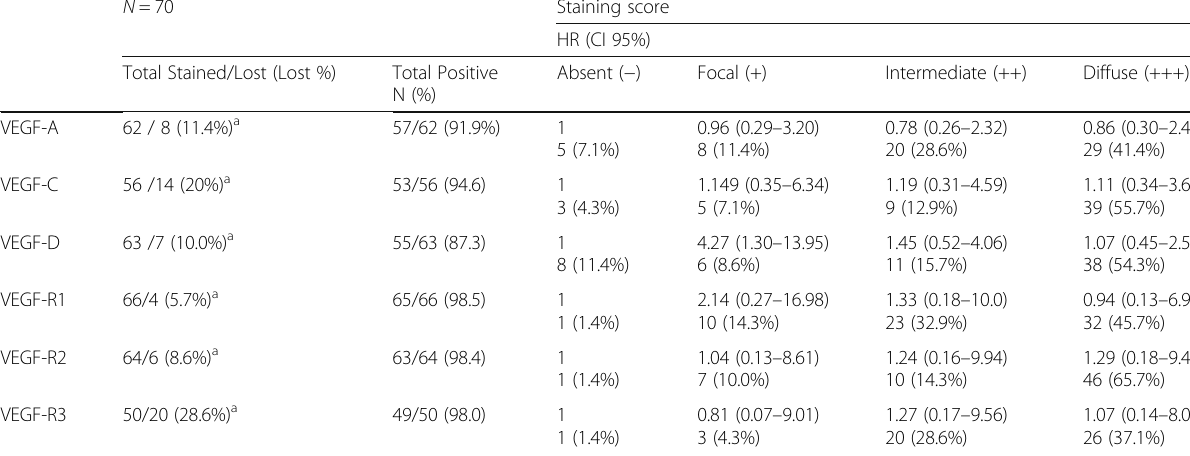
Table 4 Univariate analysis of overall survival according to the VEGF and VEGFR immunohistochemical score in GBMs N =